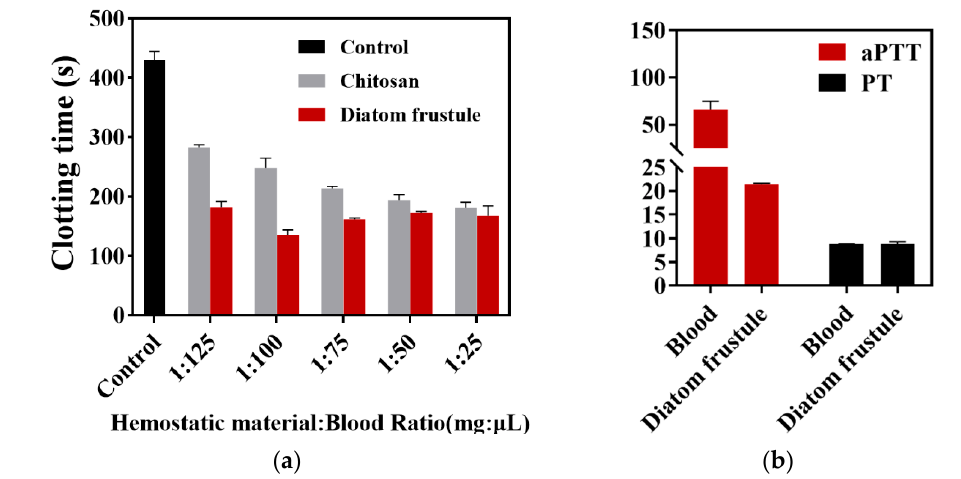
Figure 4. ( a ) In vitro clotting time of control (1 mL blood without additive), chitosan, and diatom frustules. Hemostatic materials were added to blood at ratios of 1:125, 1:100, 1:75, 1:50, and 1:25. Data represent the mean ± SD (n = 3). ( b ) The coagulation tests with aPTT and PT of diatom frustules and blood. Data represent the mean ± SD (n = 6).